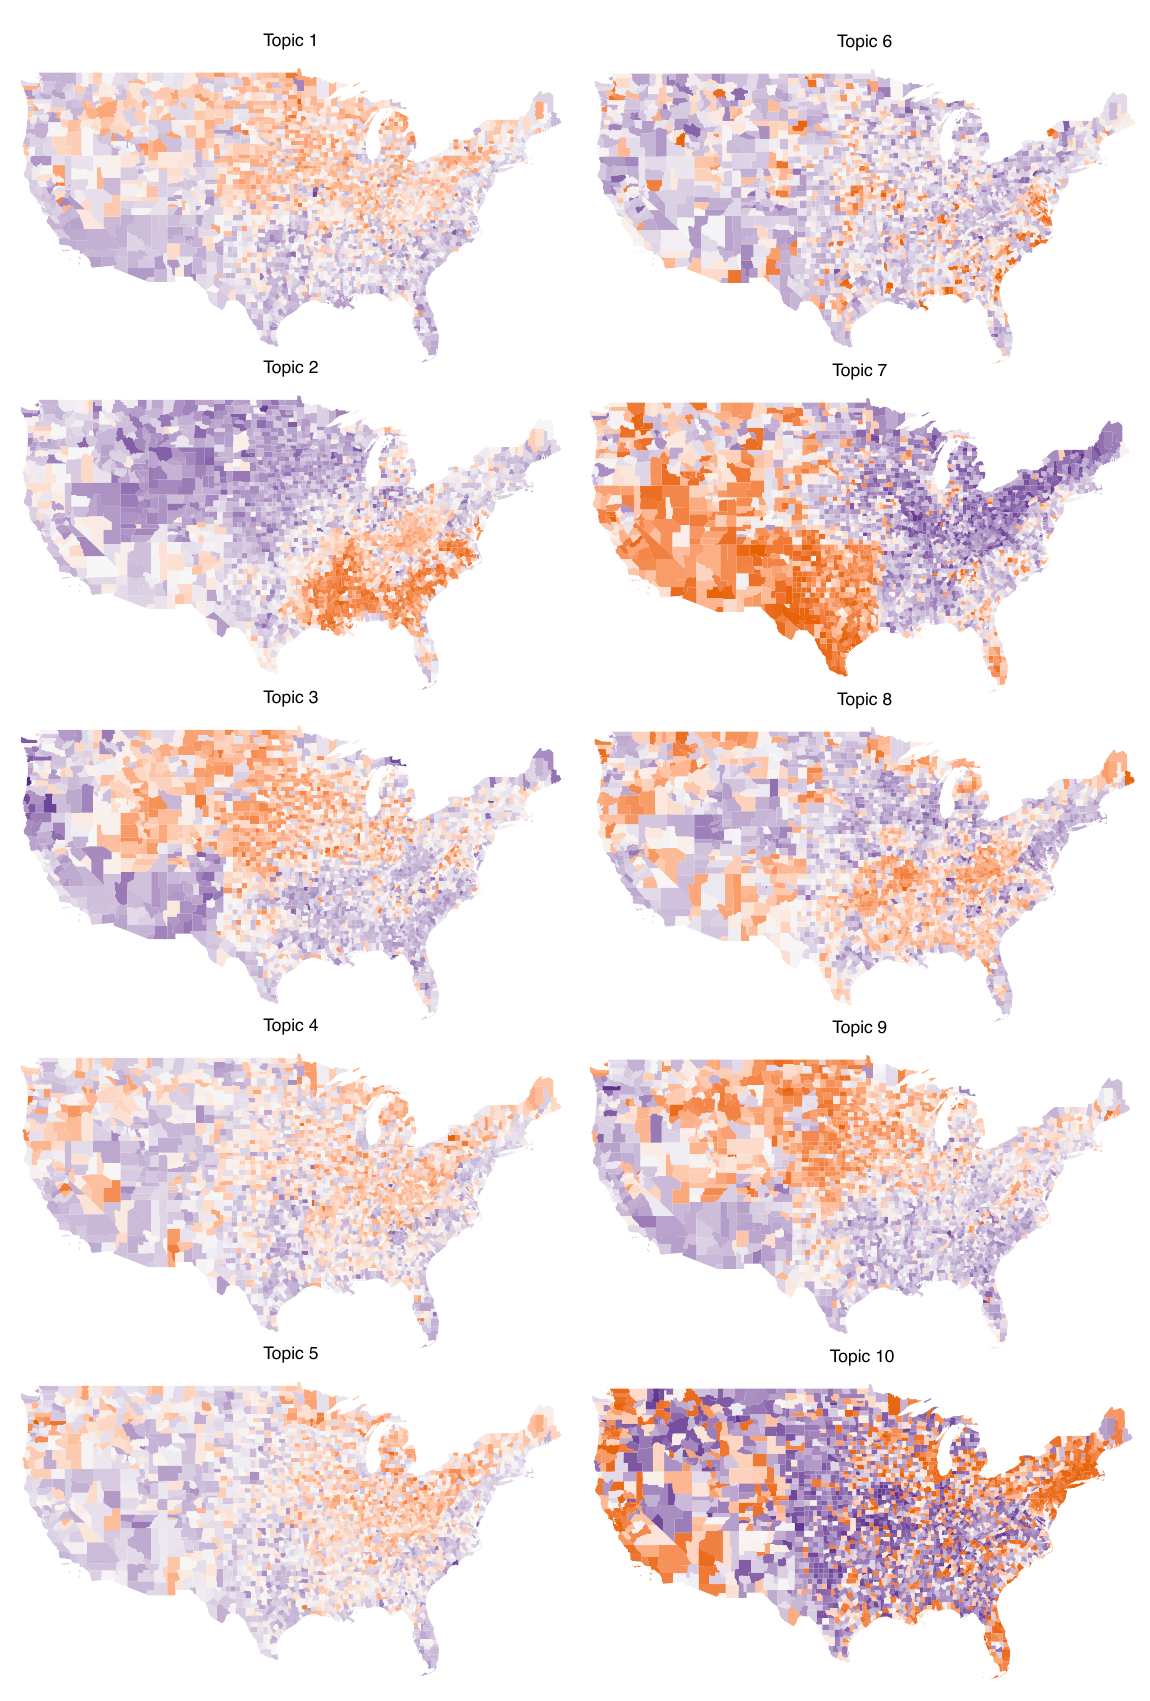
Figure A9. Normalized topic scores for each county in the US. Legend of the map is the same as the as the topic score heatmaps given in (Figure 4c,e) where given a topic, counties with colors closer to orange have a high topic value and counties with colors closer to purple have low topic